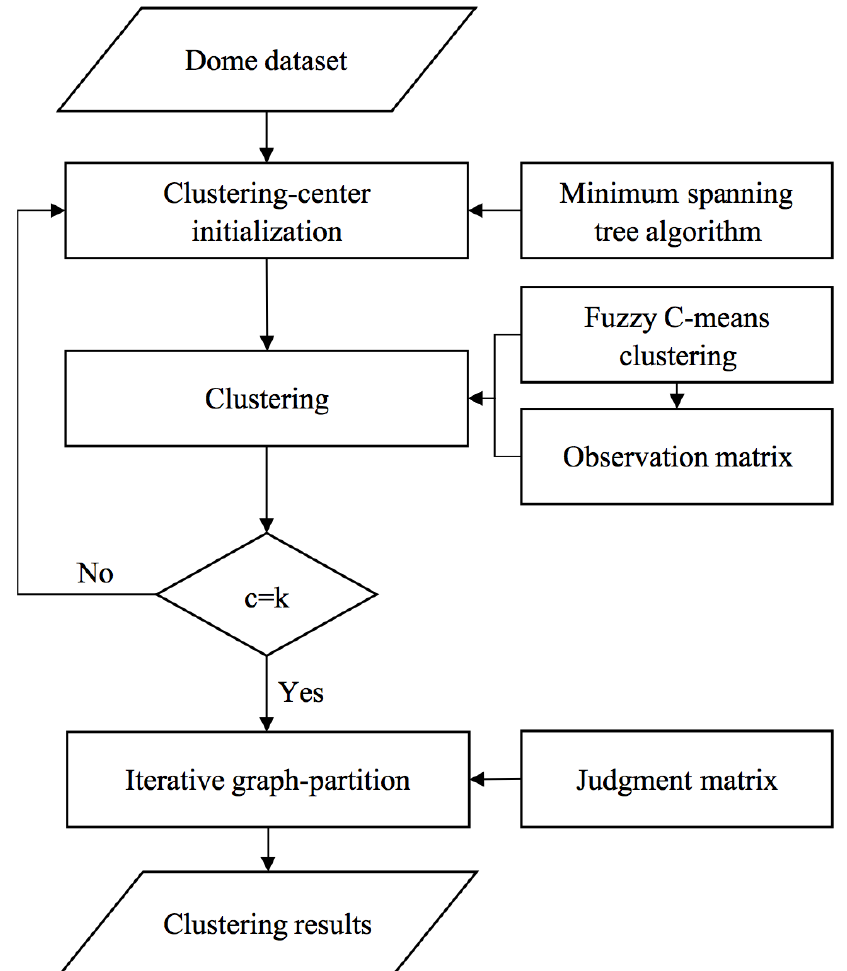
Figure 1. Flowchart of the clustering algorithm applied in this